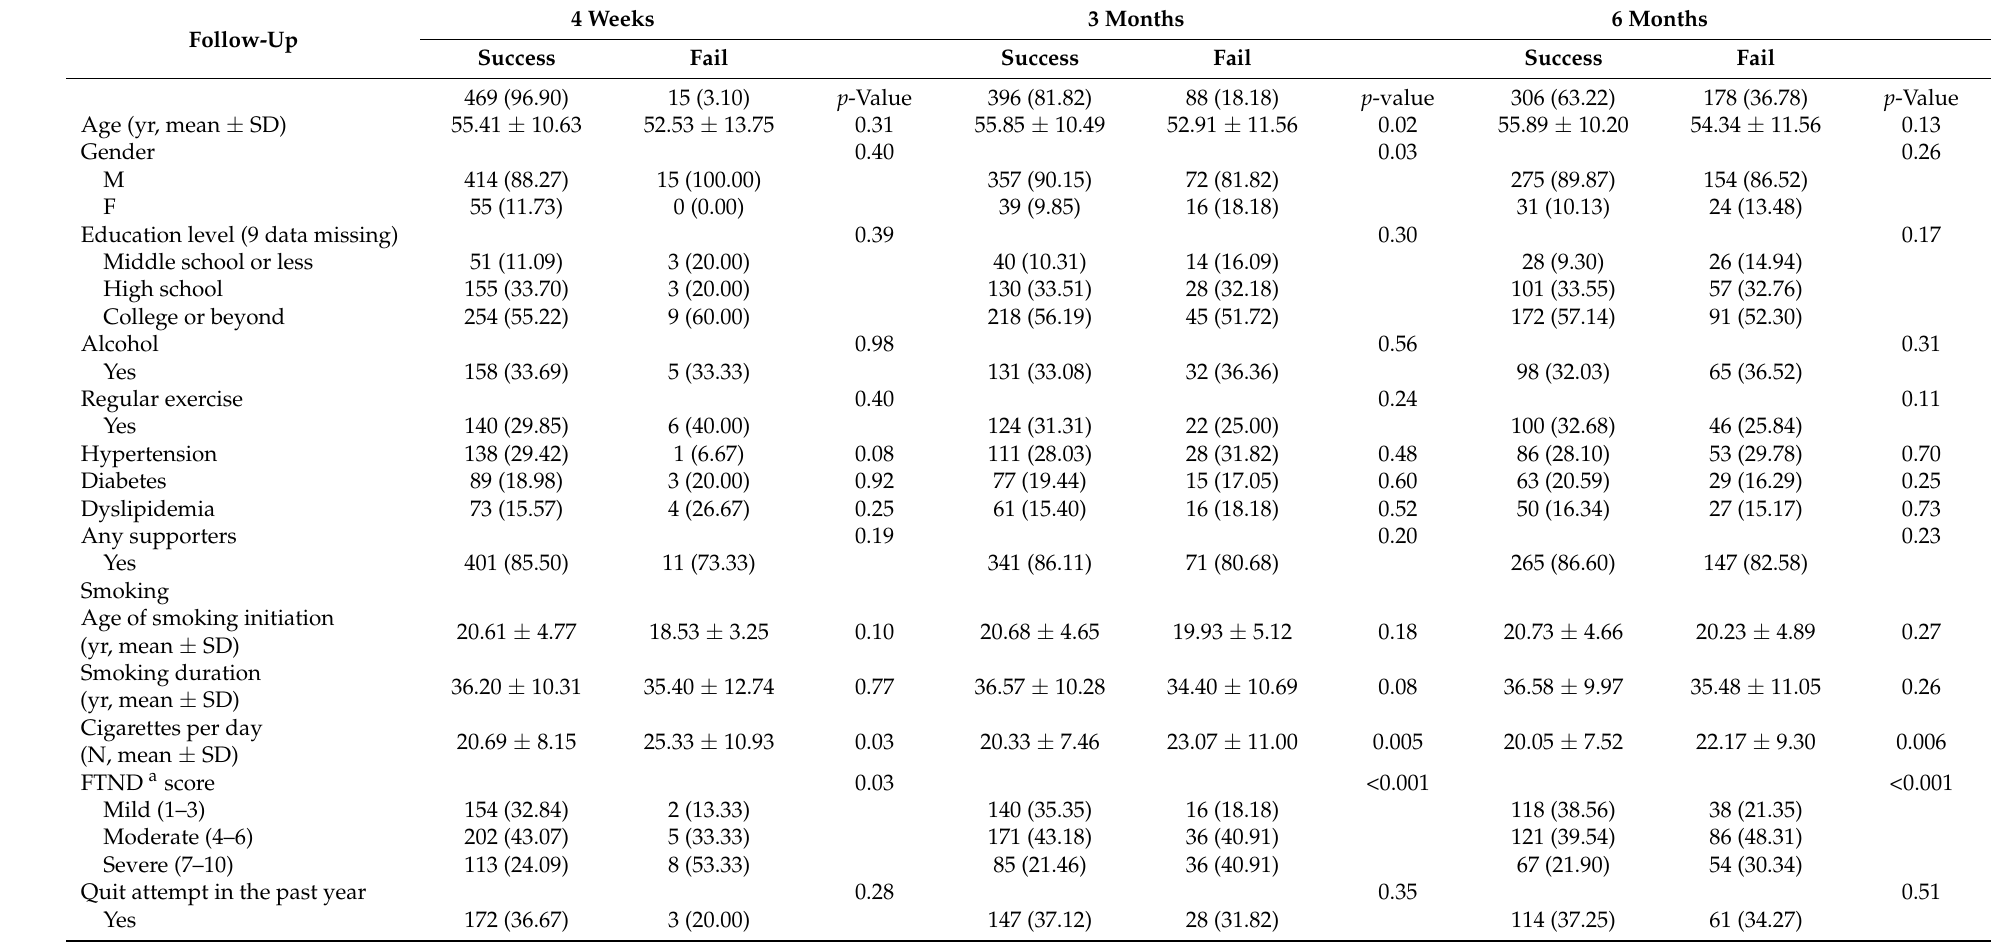
Table 3. Characteristics of participants according to 4 weeks, 3 months, and 6 months of smoking cessation